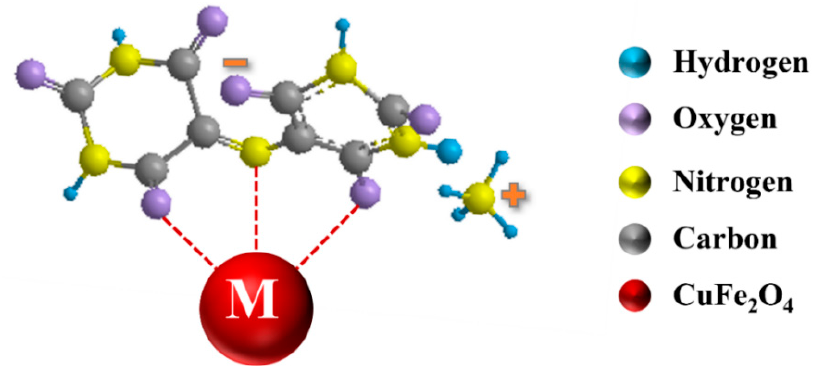
Figure 5. XRD data for (a) as-received CuFe 2 O 4 and electrodes: (b) CFO-0, (c) CFO-10, (d) CFO-20 and (e) CFO-30. CV studies of the CFO-0 electrodes showed very low currents, indicating poor pseu- docapacitive properties (Figure 6A). The low currents and small CV areas were observed due to the low electronic conductivity of CFO-0. High electronic conductivity is one of the key factors for the efficient charge–discharge of pseudocapacitive materials. The addition of conductive MCNT and the efficient co-dispersion of CuFe 2 O 4 and MCNT resulted in the capacitive behavior of CFO-10, CFO-20 and CFO-30 electrodes (Figure 6B–D). CFO- 10, CFO-20 and CFO-30 electrodes showed nearly rectangular-shape CVs, indicating good pseudocapacitive behavior and fast kinetic charge–discharge reactions. The observed in- crease in current with increasing scan rate was another indicator of good pseudocapaci- tive properties of the electrodes. It is suggested that capacitive properties of CFO in the